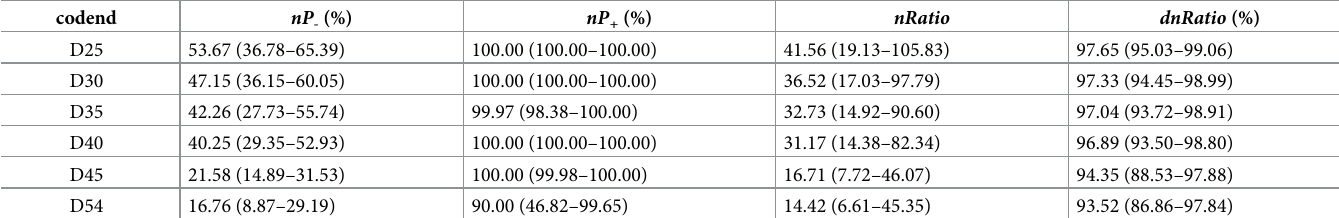
Table 5. The exploitation pattern indicators obtained for the tested codends.